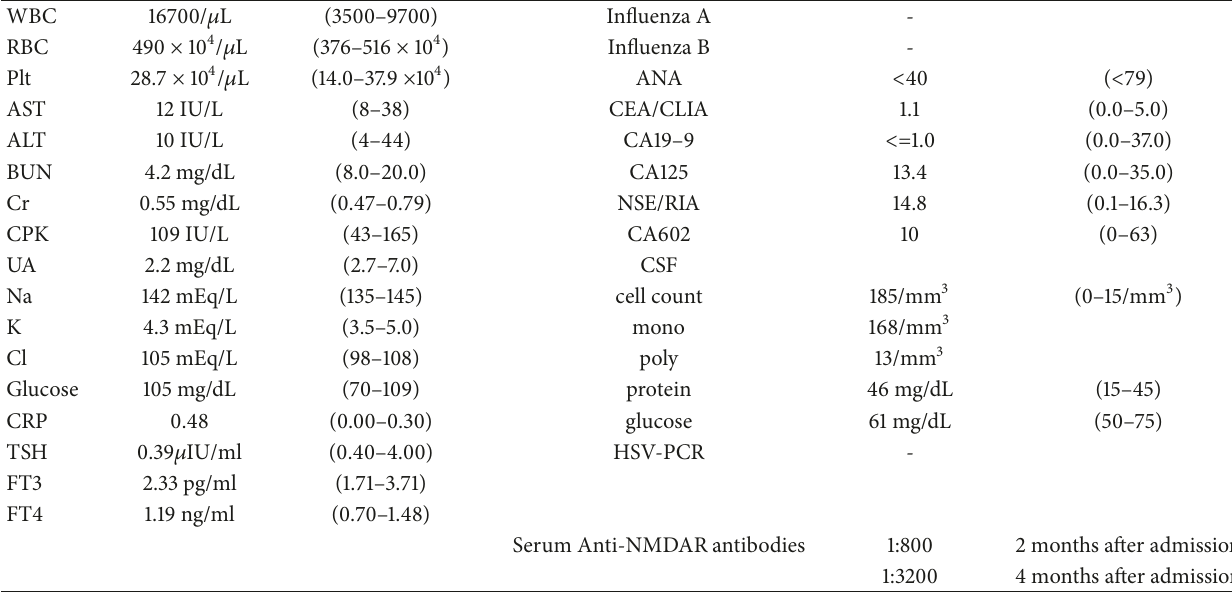
Table 1: Laboratory data.